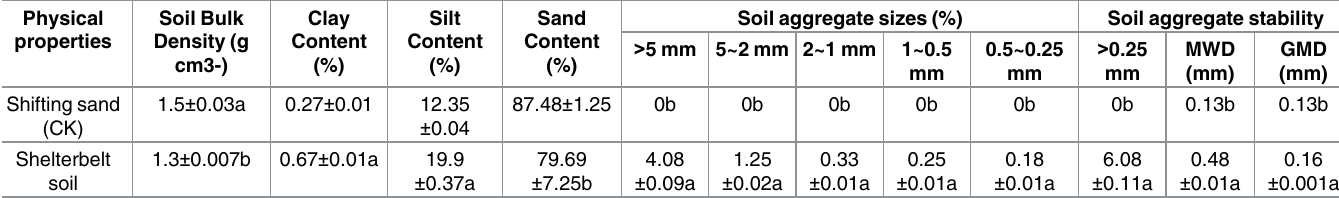
Shelterbelt soil Note: MWD presents the mean weight diameter, GMD presents geometric mean diameter and CK presents the shifting sand, the different letters give significant difference at P =